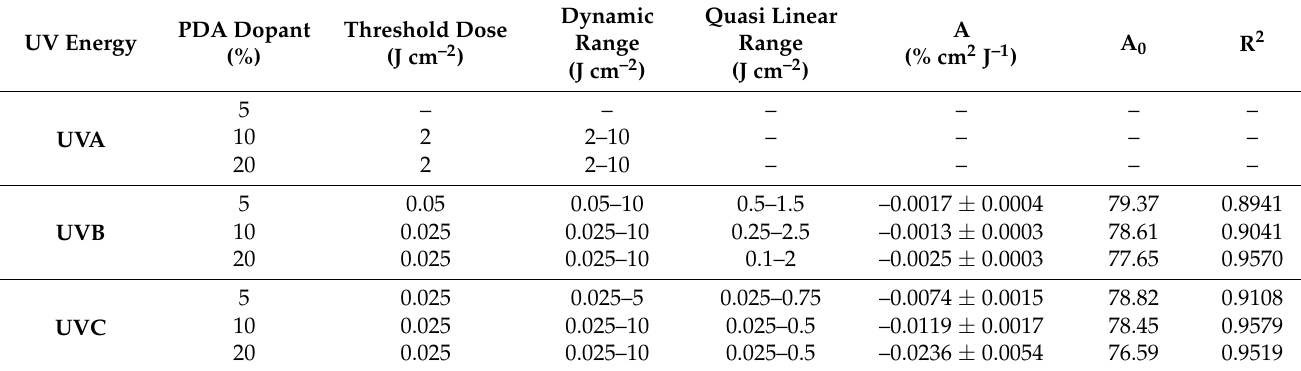
Table 2. Elementary characteristics of UV-irradiated paper samples with PAN–PDA fibres dopant (non–refined paper) (A denotes the slope of the linear regression that is the dose